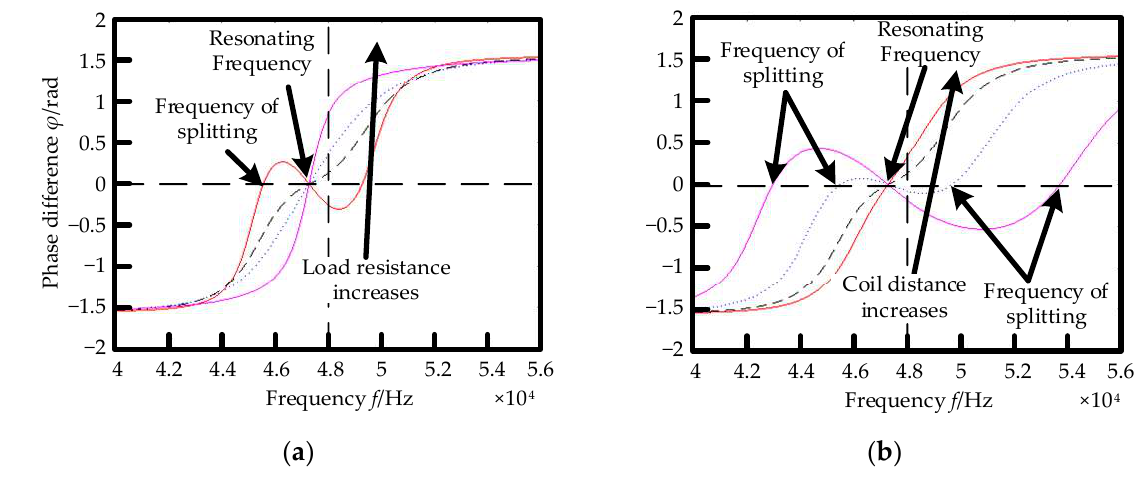
Figure 3. The relationship between the phase difference and operating frequency: ( a ) distance fixed, resistance increases; ( b ) resistance fixed, distance increases.